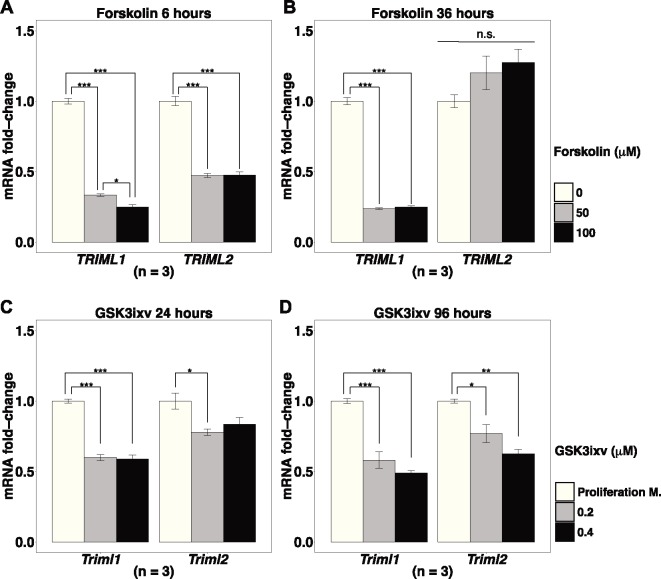

TRIML1 and TRIML2 expression during trophoblast differentiation. (A and B) TRIML1 and TRIML2 expression differ during forskolin-induced BeWo cell syncytialization. (C and D) GSK3ixv-induced mouse TSCs differentiation into syncytiotrophoblast layer II causes downregulation of both Triml1 and Triml2. Expression levels normalized to control groups. Values are mean ± SEM. One-way ANOVA, Tukey’s HSD, ***P < 0.001, **P < 0.01, *P < 0.05. n.s., not statistically significant.